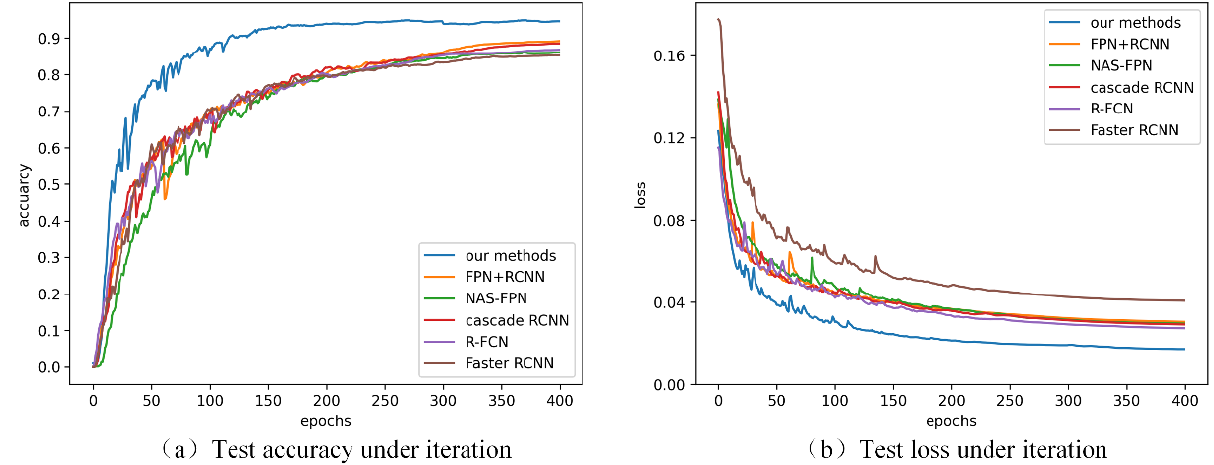
Figure 13. Test accuracy ( a ) and loss ( b ) of the proposed method and some typical two-stage detection algorithms in the DR datasets.